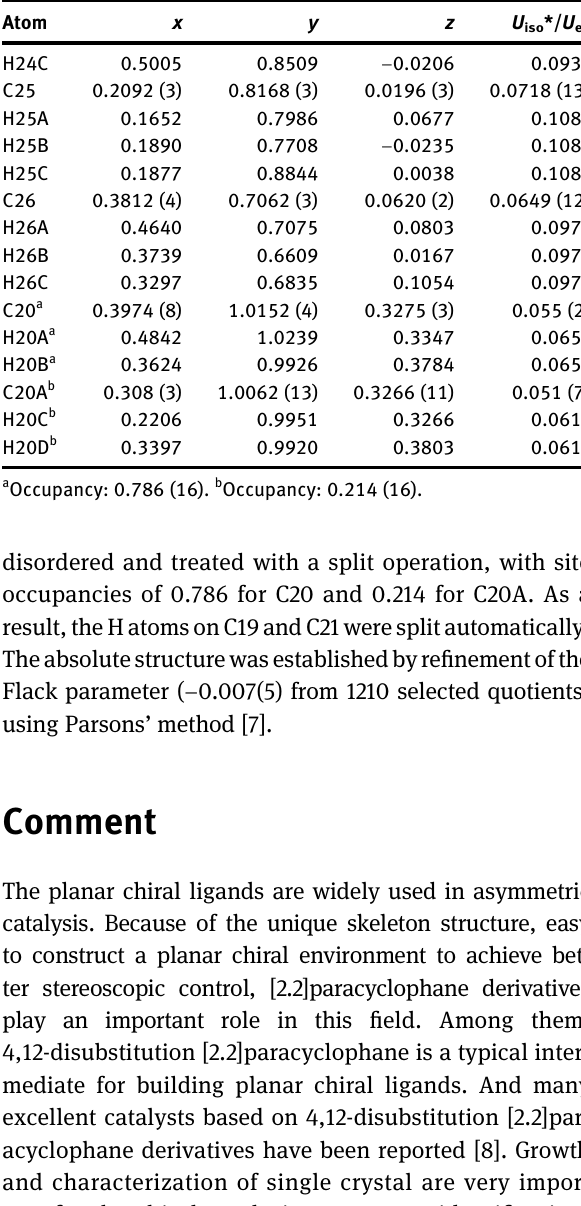
Table  : Fractional atomic coordinates and isotropic or equivalent isotropic displacement parameters (Å 